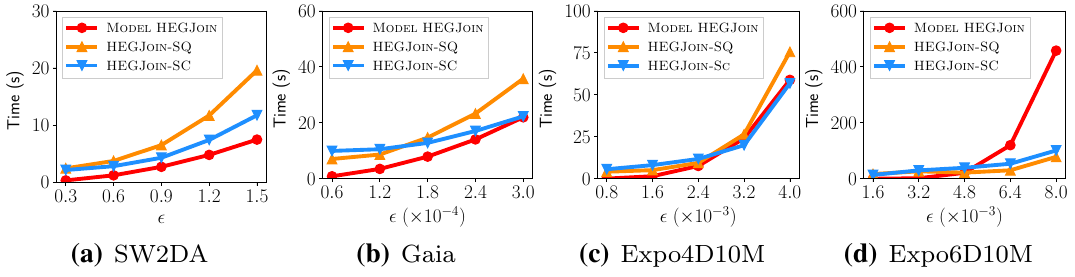
Fig. 9 Comparison of the modeled execution time of HEGJ oin as determined by the static partitioning model vs. the response time of HEGJ oin - SQ and HEGJ oin -SC on a selection of datasets: a SW2DA , b Gaia , c Expo4D10M and d Expo6D10M . Results from Platform